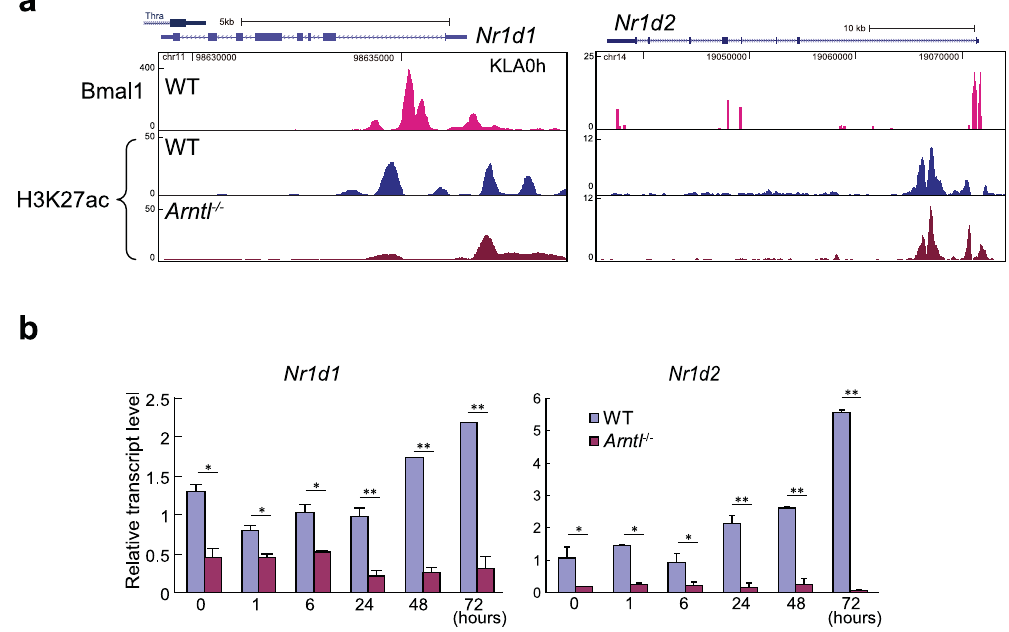
Figure 7. Nr1d1 and Nr1d2 expression is suppressed in Arntl − / − macrophages. ( a ) Genome browser snapshots of Bmal1 and H3K27ac ChIP-seq and RNA-seq results at Nr1d1 and Nr1d2 loci. ( b ) Relative expression of Nr1d1 and Nr1d2 mRNA in WT and Arntl − / − macrophages treated with KLA for indicated times. n = 3 for each group at each time point. * p < 0.05, ** p < 0.01. between WT and Arntl − / − at the same time